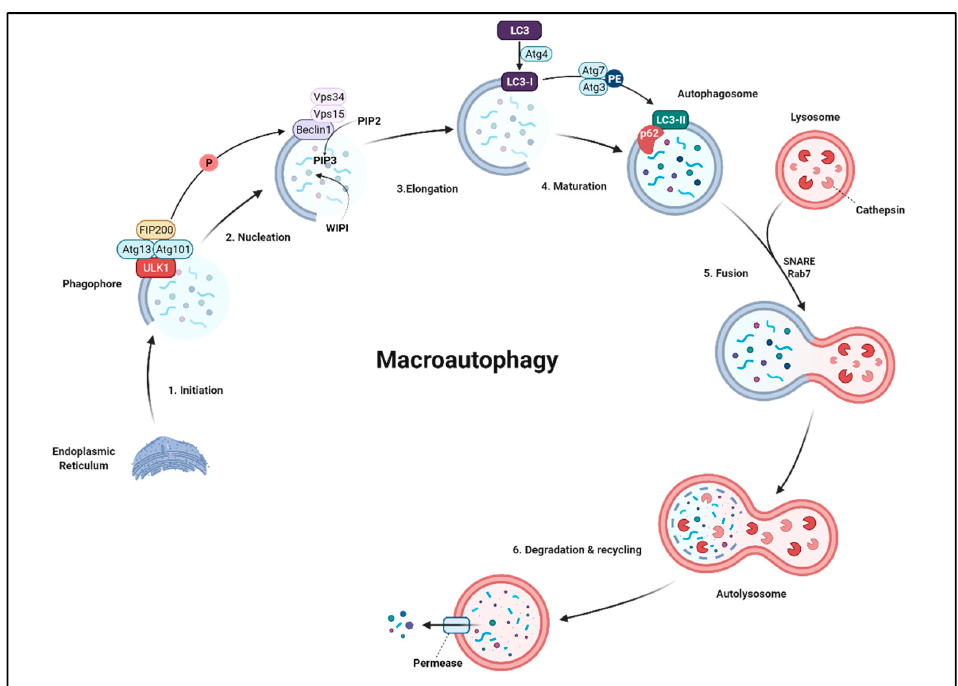
Figure 6. Macroautophagy: There are several steps in the formation of a phagophore, its maturation into an autophagosome, and, finally, fusion with the lysosome to degrade the cargo and recycle macromolecules for further use. The illustration is created with BioRender.com.